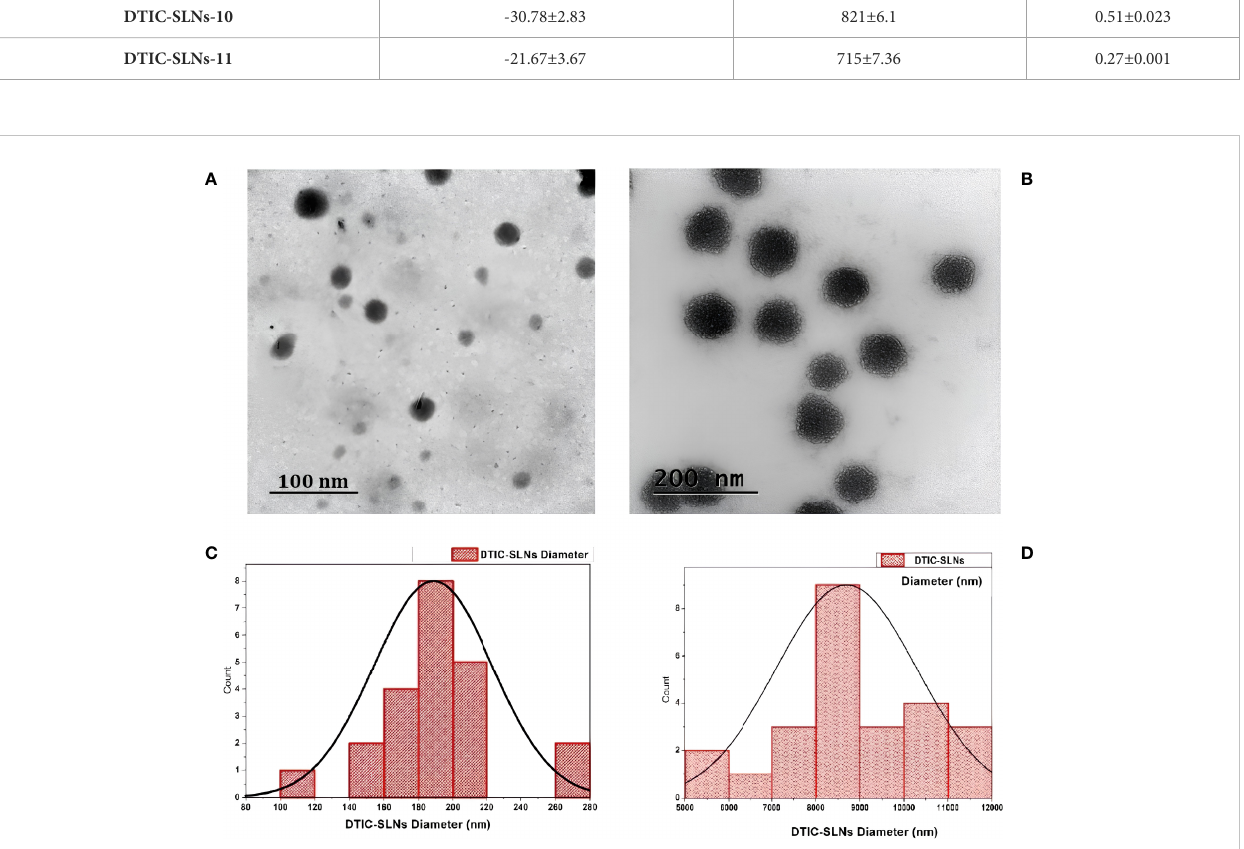
FIGURE 2 Transmission electron microscopy (TEM) images of the prepared DTIC-SLNs-9 at 100 nm scale (A) and 200 nm scale (B) . The histogram of DTIC- SLNs diameters indicating 188.70nm as average diameter with 34.66nm standard deviation (C) . The mean surface area of DTIC-SLNs was found to be 8693.63 nm 3 with a standard deviation of 1600.66 nm 3 (D) .